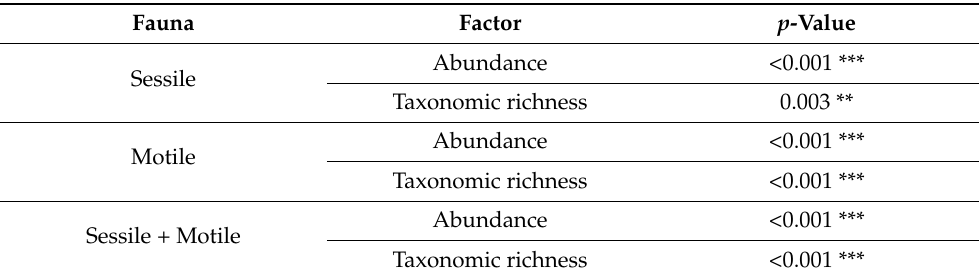
Table 2. Results of the ANOVA test corresponding to the interaction effect of the year on the sessile fauna found on the ten blocks sampled from 2014 to 2018 for Taxonomic Richness and abundance